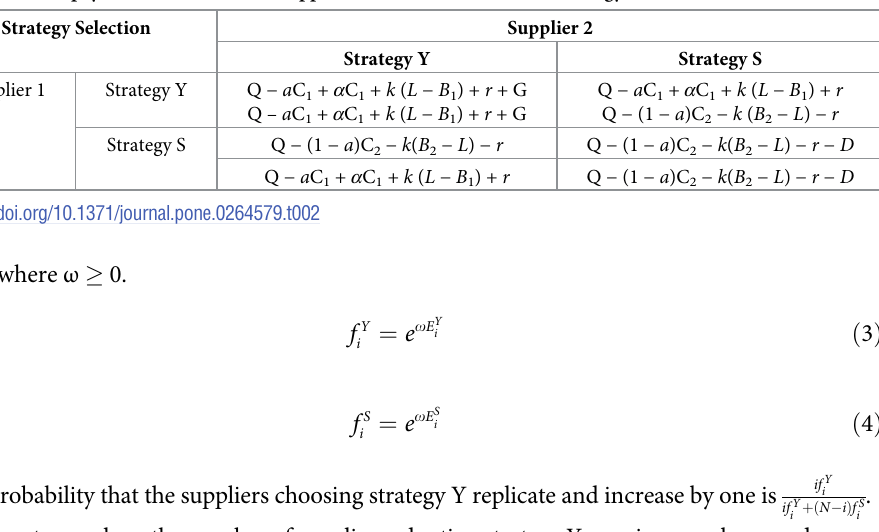
Table 2. Game payoffs matrix under the supplier choice carbon emissions